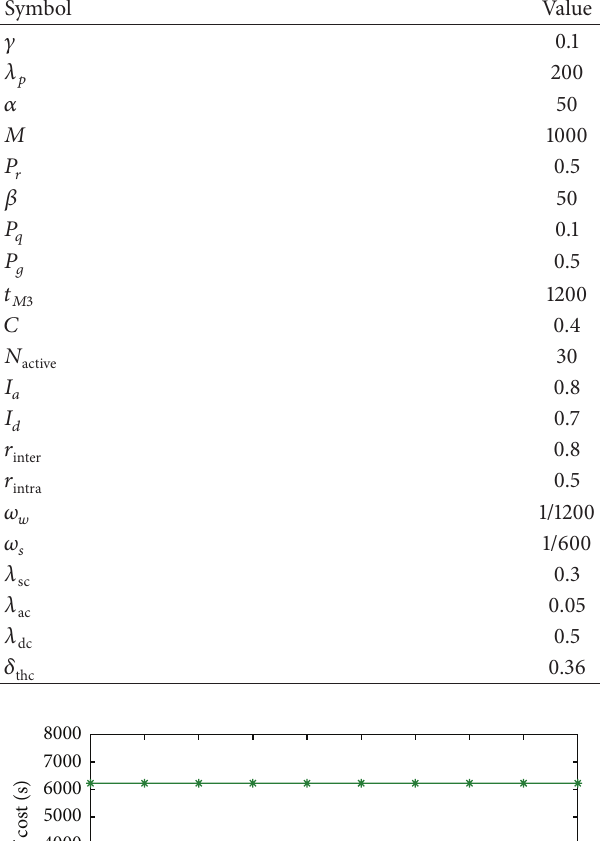
Table 2: Default parameter values.